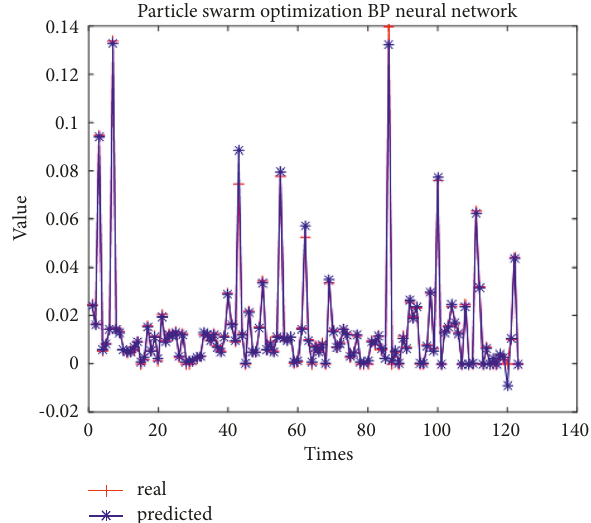
Figure 4: PSO-BP algorithm-based comparison of true and pre- dicted values.